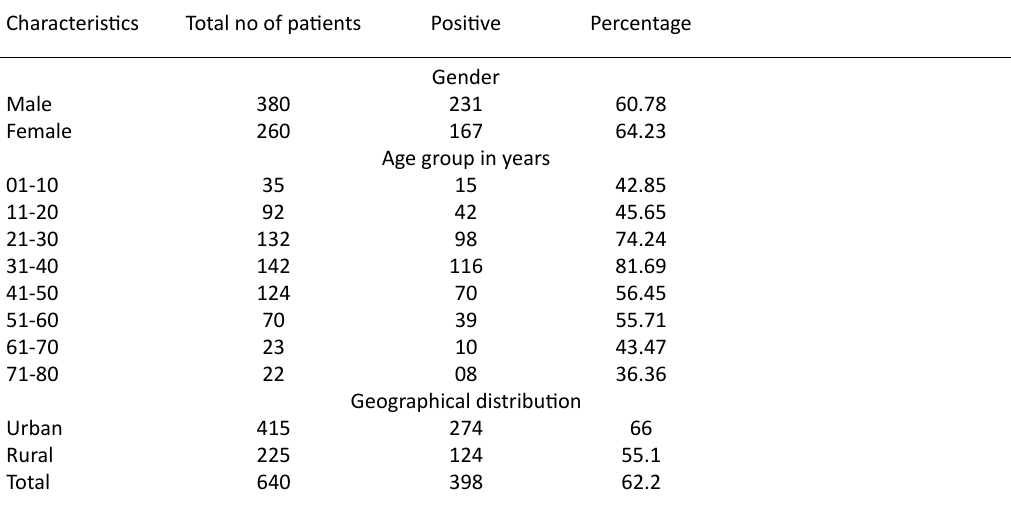
Table 1. Demographic characteristic of Patient (n=640) Characteristics